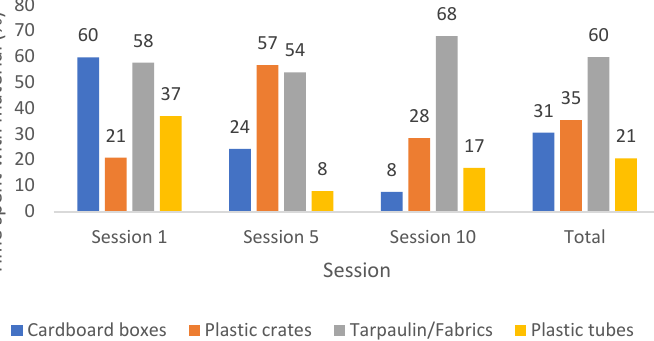
Figure 2. Percentage of time children spent playing with each material by session and in the total of the three sessions.